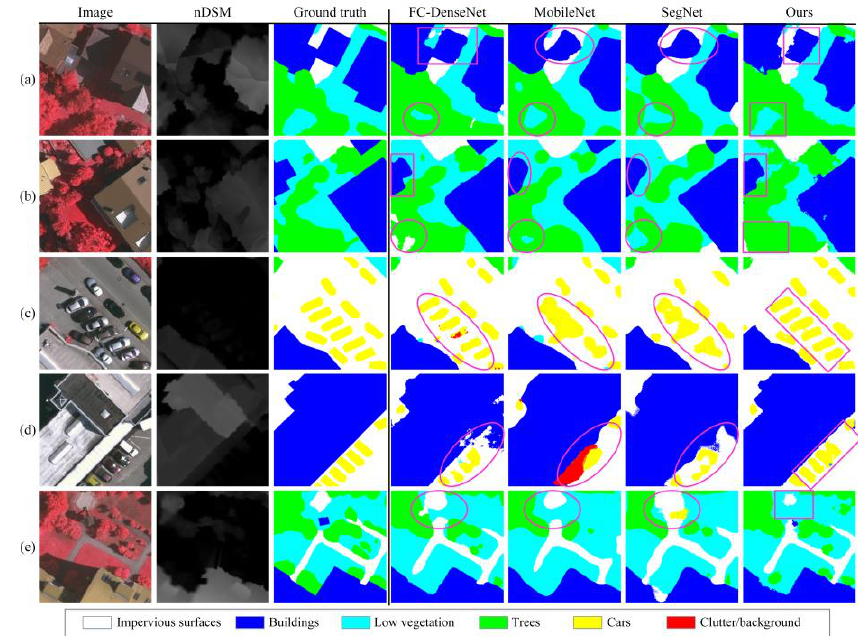
Figure 7. Examples of land cover classification results on the Vaihingen dataset. The rectangles in pink and the circles in pink represent correct and incorrect classification, respectively. ( a – e ) are five subsets land cover classification results from Vaihingen dataset.